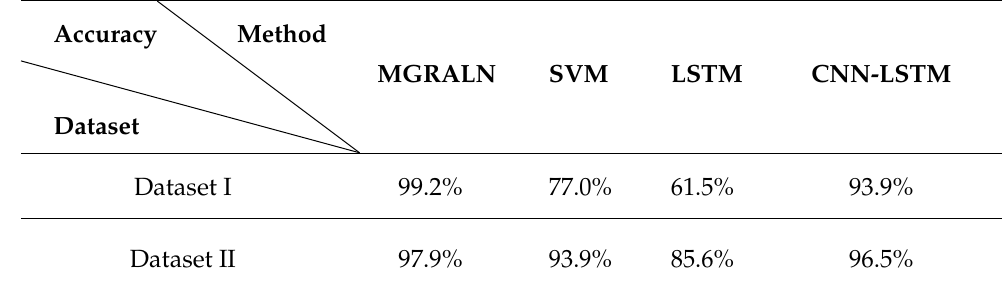
Table 3. Accuracy comparisons of MGRALN with the mainstream methods on the dataset I and dataset II when the training ratio is